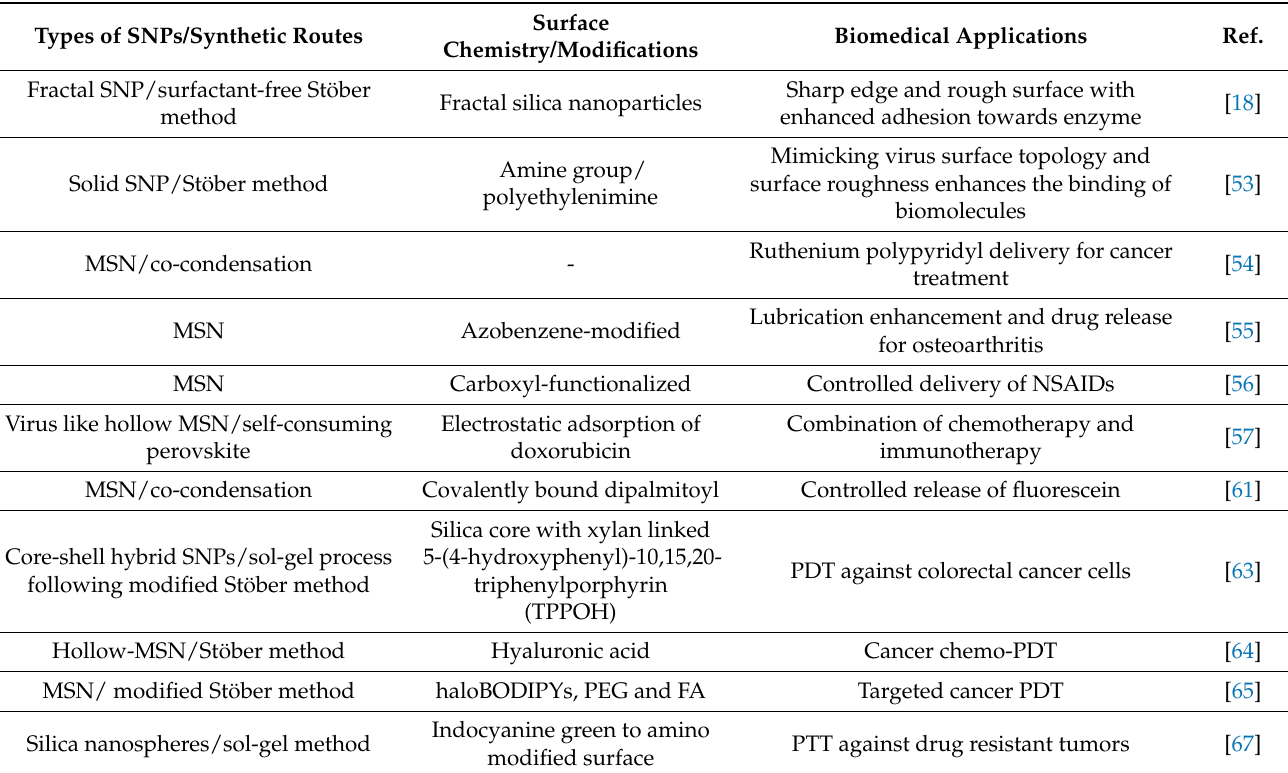
Table 3. Summary of important silica nanoparticles (SNPs) in theranostics. Types of SNPs/Synthetic